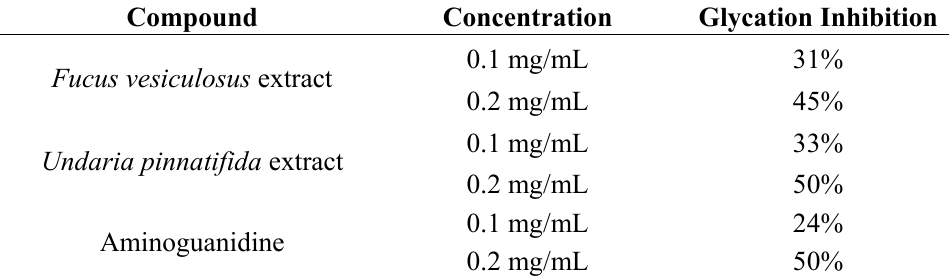
Table 4. Extract glycation inhibition results (percent inhibition).